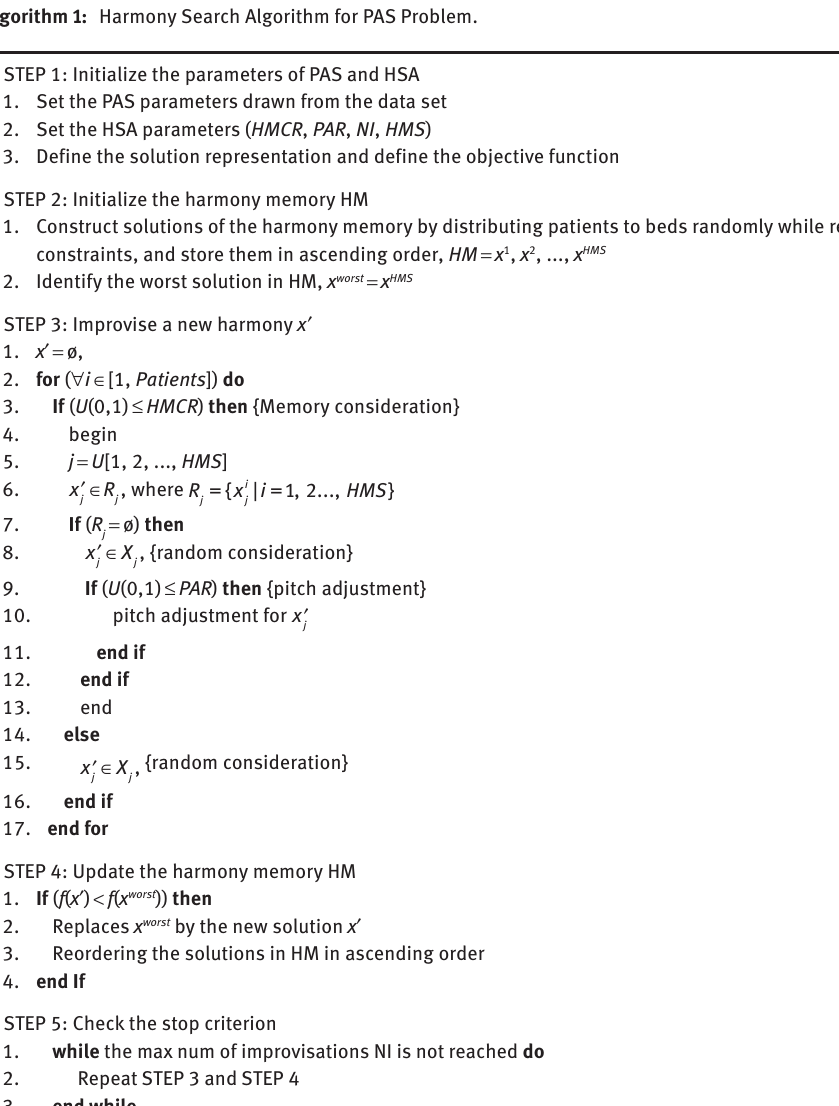
Algorithm 1: Harmony Search Algorithm for PAS